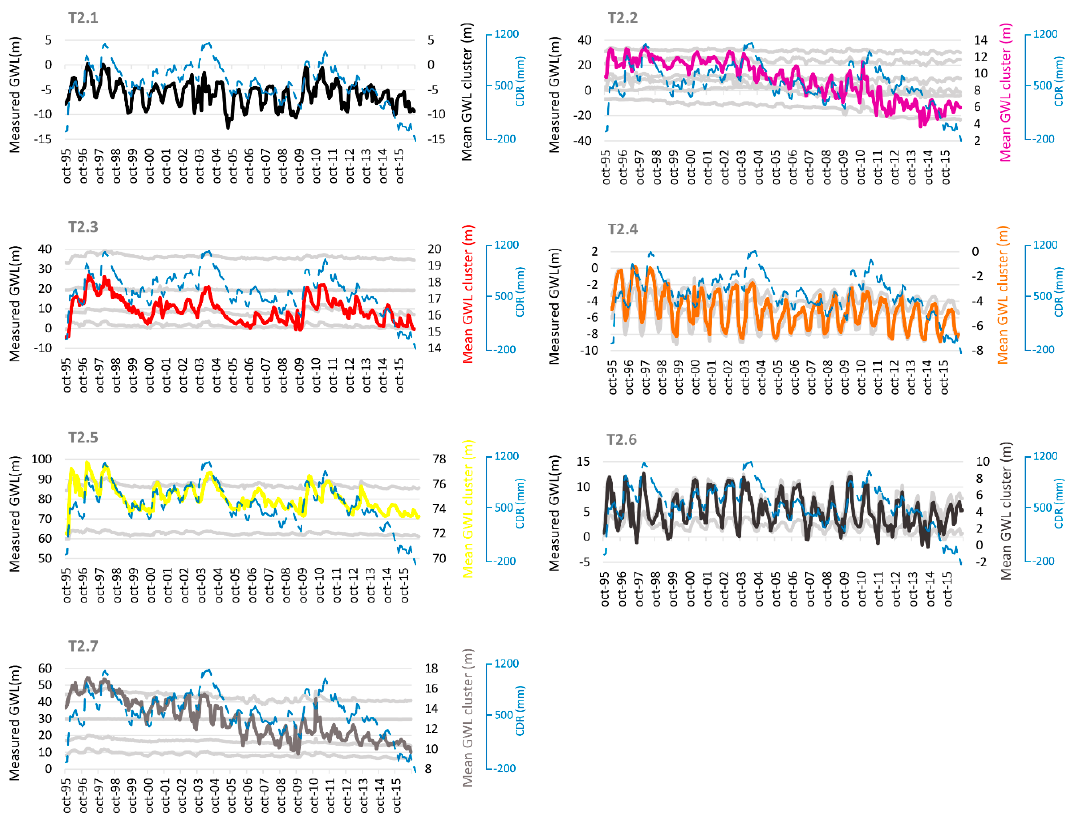
Figure 11. GWL series (grey lines), mean of the GWL cluster series (colored line) from October 1995 to September 2016 (second sub-period), classified by TSC, and cumulative deviation from the mean monthly Rainfall (CDR).